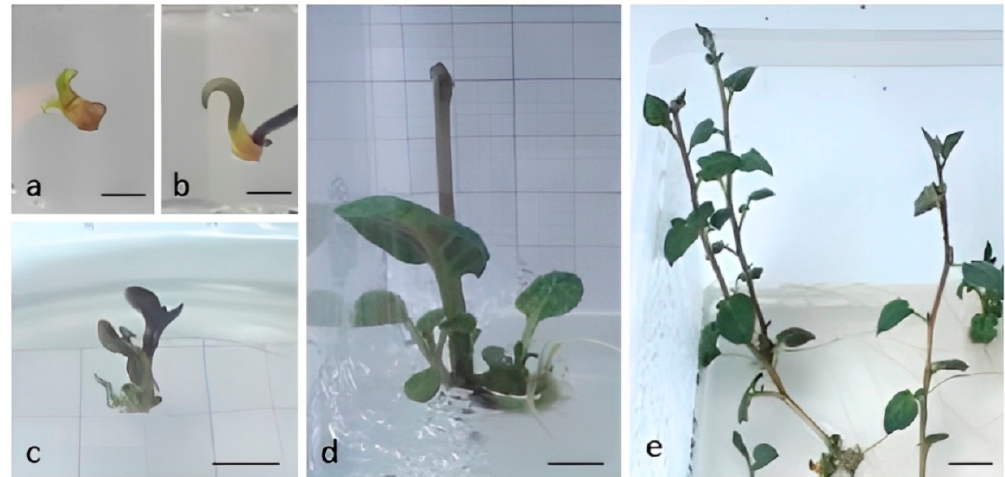
Figure 1. Surviving explants after 6 weeks of growth on ribavirin ( a , b ); inhibited growth on HFMS medium 100 days from the start of the experiment—shoot originating from RIB 50 ( c ) and RIB 100 ( d ); micropropagation by single node culture ( e ). Bars: ( a , b ) = 2 mm; ( c , d ) = 5 mm; ( e ) = 10 mm.